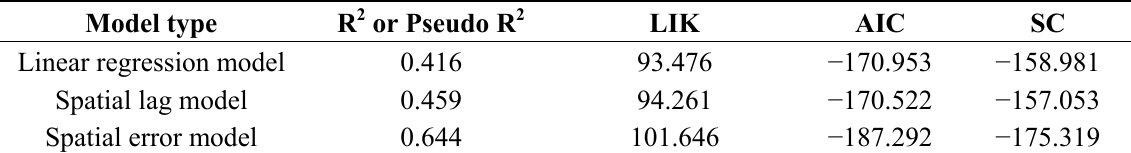
Table 5. Statistical tests of three regression